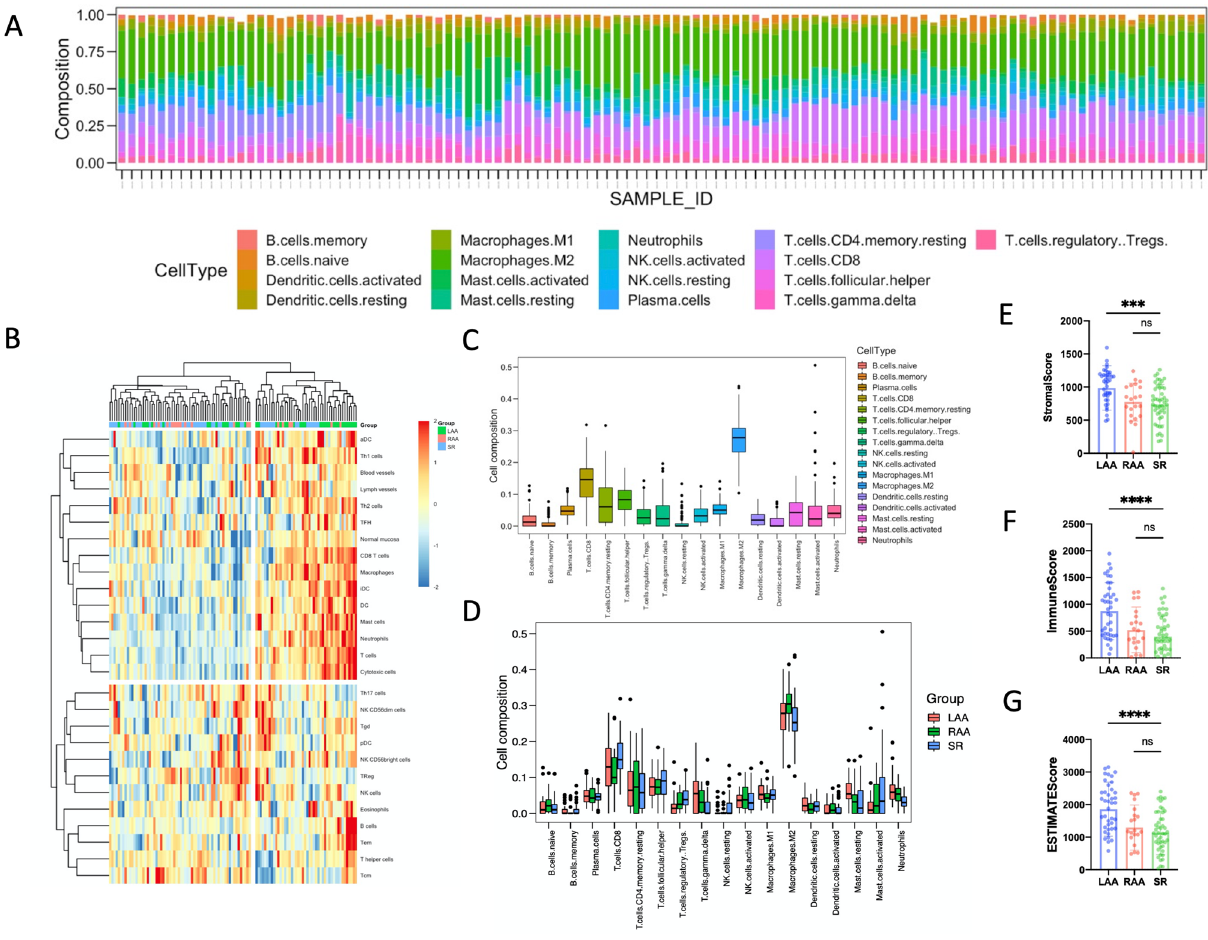
Figure 2. Immune cluster characterization and cell abundance. ( A ) Relative expression of 17 immune cell abundance stacked column charts in each sample estimated using CIBERSORT. ( B ) Immune cluster characterization heatmap using ssGSEA (‘GSVA’ package). ( C ) Immune cell abundance histogram of all included samples estimated using CIBERSORT. ( D ) Immune cell abundance histogram of different groups estimated using CIBERSORT. ( E ) Stromal score of three different groups using ESTIMATE. ( F ) Immune score of three different groups using ESTIMATE. ( G ) ESTIMATE score of three different groups using ESTIMATE. Data are presented as the mean ± SD. * p < 0.05, ** p < 0.01, *** p < 0.001, and **** p <